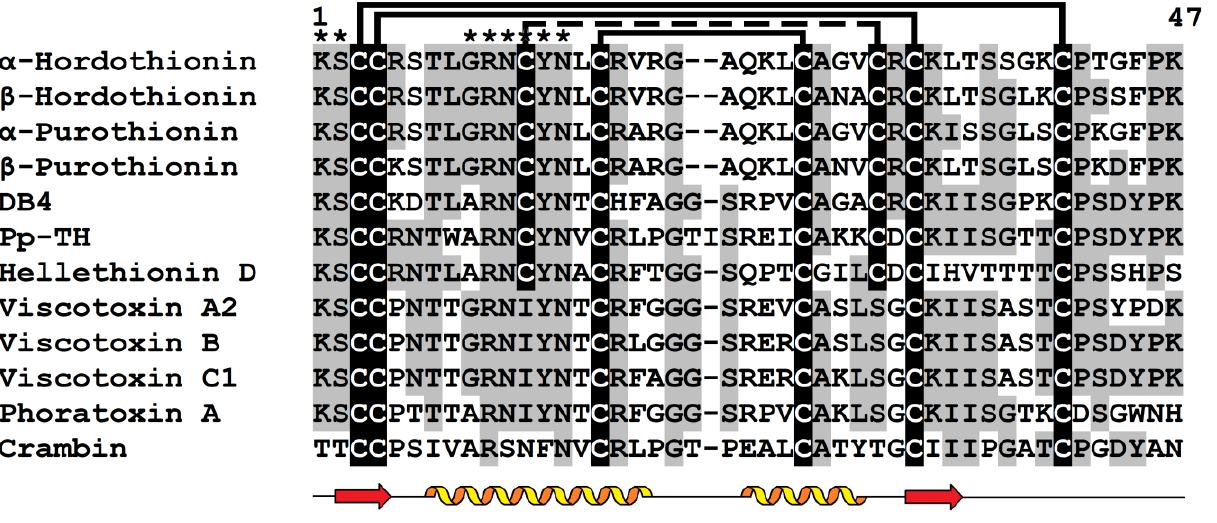
Figure 1. Multiple sequence alignment of selected thionins: α -hordothionin (GenBank AAA32966.1) and β -hordothionin (GenBank 1206255A) from Hordeum vulgare ; α -purothionin (GenBank CAA65313.1) and β -purothionin (GenBank CAA65312.1) from Triticum aestivum , leaf-specific thionin DB4 from H. vulgare (UniProt P08772.2); Pp-TH from Pyrularia pubera (UniProt P07504.1); hellethionin D from Helleborus purpurascens (UniProt P60057.1); viscotoxin А2 ( UniProt P32880.1), В ( GenBank P08943.2), and С1 ( UniProt P83554.1) from Viscum album ; phoratoxin А from California mistletoe (UniProt P01539.1); crambin from Crambe abyssinica (UniProt P01542.2). Cysteine residues are highlighted in white on the black background. Conserved amino acid residues are highlighted in black on the grey background. Lines above the sequences denote disulfide bonds. Asterisks indicate conserved amino acid residues supposed to be involved in interactions with phospholipids. Secondary structure elements (α - heliсеs and β - strands) for β -purothionin (PDB 1BHP) are shown under the alignment as helices and arrows, respectively.